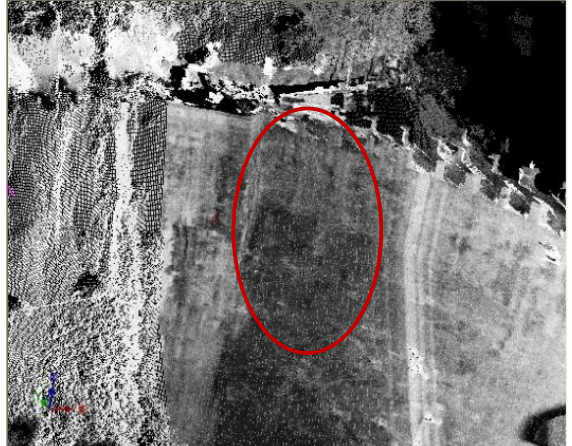
Figure 10. A view of intensity 3D point cloud of the dam. The red circle shows the dam area affected by water infiltration